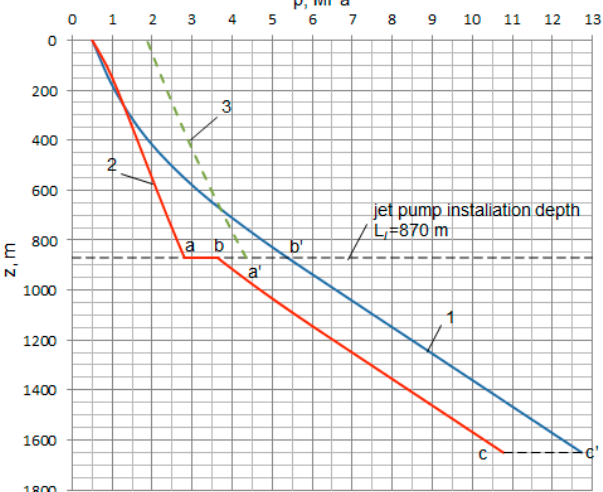
Figure 5. Pressure distribution between the sucker-rod pump and the wellhead: 1—without the jet pump; 2—with the jet pump ( f 3 / f 1 = 3); 3—with the jet pump after decreasing inlet pressure p w = 5.381 М P а .